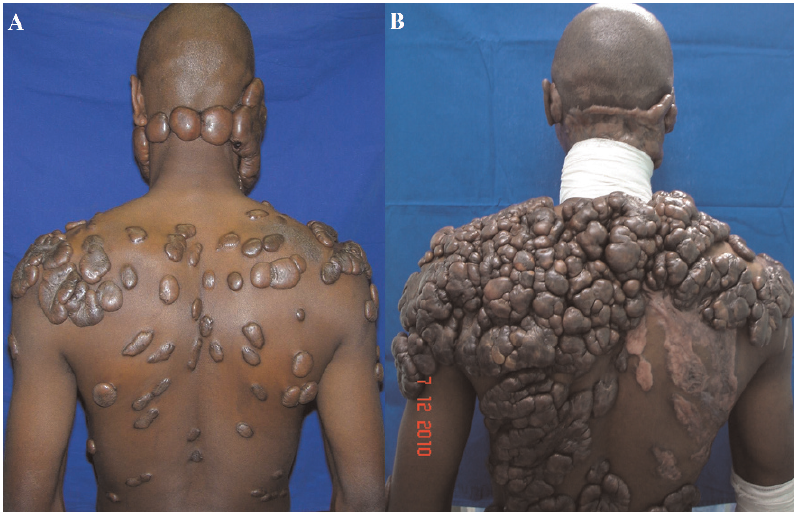
Figure 2 - Keloid evolution after seven years (A and B). Keloids continue to evolve over time, without a quiescent or regressive phase, and infiltrate the surrounding